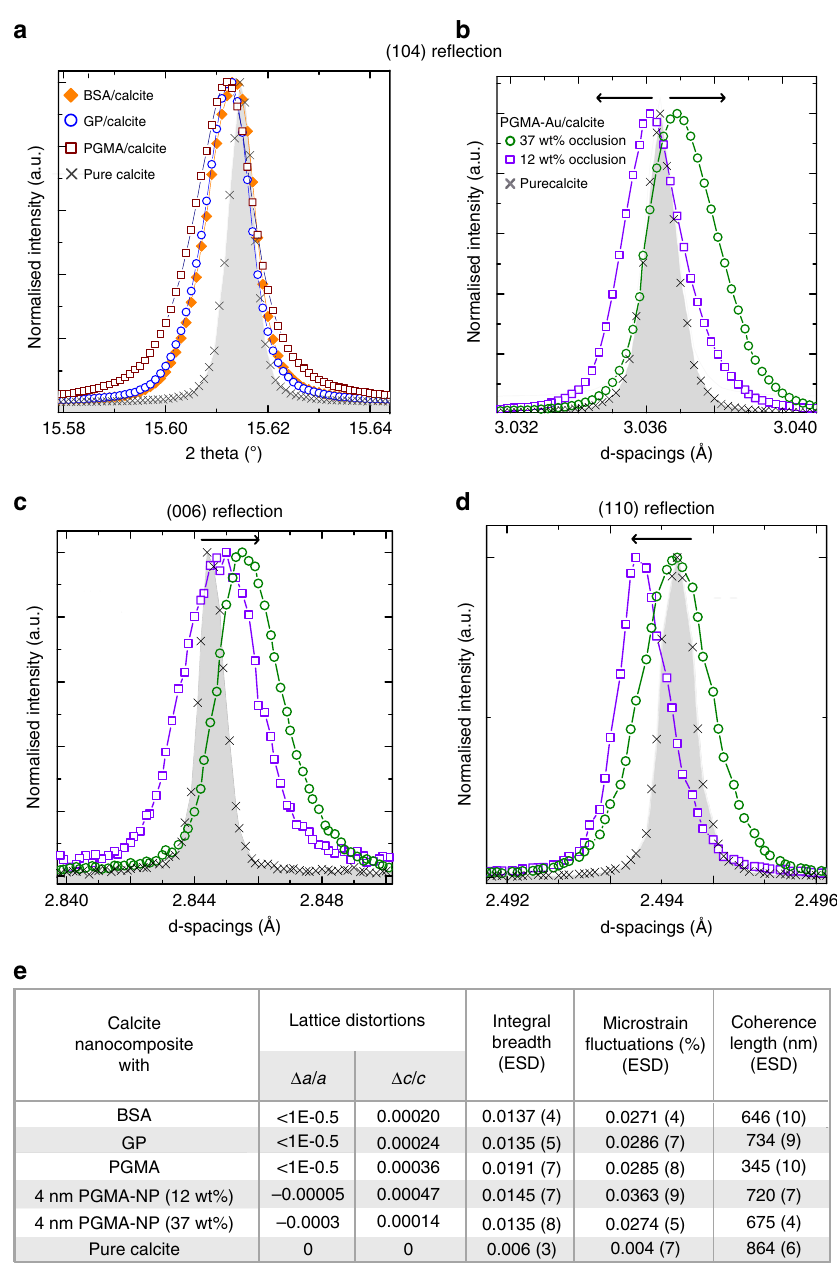
Fig. 8 Powder XRD microstructure analysis of the protein/calcite and PGMA-NPs/calcite crystals. a {104} re fl ections of calcite crystals grown in the presence of proteins (BSA and GP) or PGMA, showing small shifts to larger d -spacings (lattice expansion) and peak broadening. b – d {104}, {006}, and {110} re fl ections obtained using high-resolution synchrotron powder XRD from calcite crystals with 12 wt% occlusion and 37 wt% occlusion. A shift to larger d -spacing is observed along the c -axis (expansion, seen in the {006} re fl ection ( c )), and to a smaller d -spacing along the a -axis (contraction, as seen in the {110} re fl ection ( d )). {104} re fl ections showed a transition from lattice expansion (12 wt% occlusion calcite) to contraction (37% occlusion calcite). e Summary of the strains and coherence lengths, where the lattice distortion and strain parameters were obtained using Rietveld analysis and line pro fi le analysis,